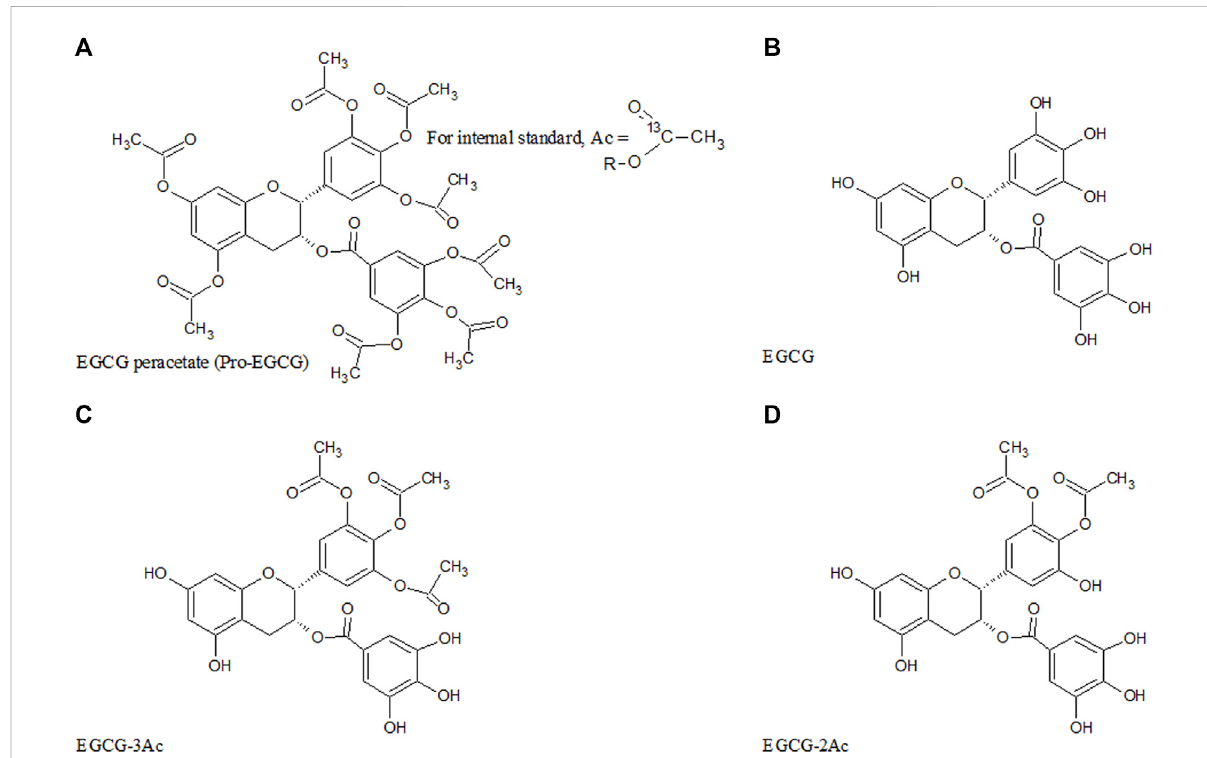
FIGURE 1 Chemical structure of pro-EGCG and metabolites. Diagrams show the chemical structure of (A) pro-EGCG, (B) EGCG, and the proposed structure of isomer of (C) EGCG-3Ac, and (D)